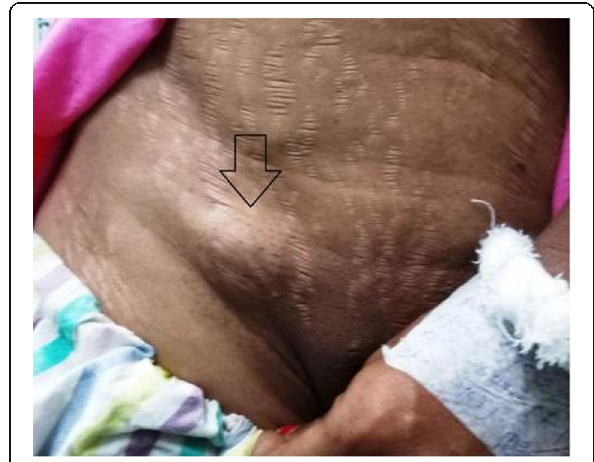
Fig. 1 Preoperative image of the right inguinal swelling (below the inguinal ligament and lateral to the pubic